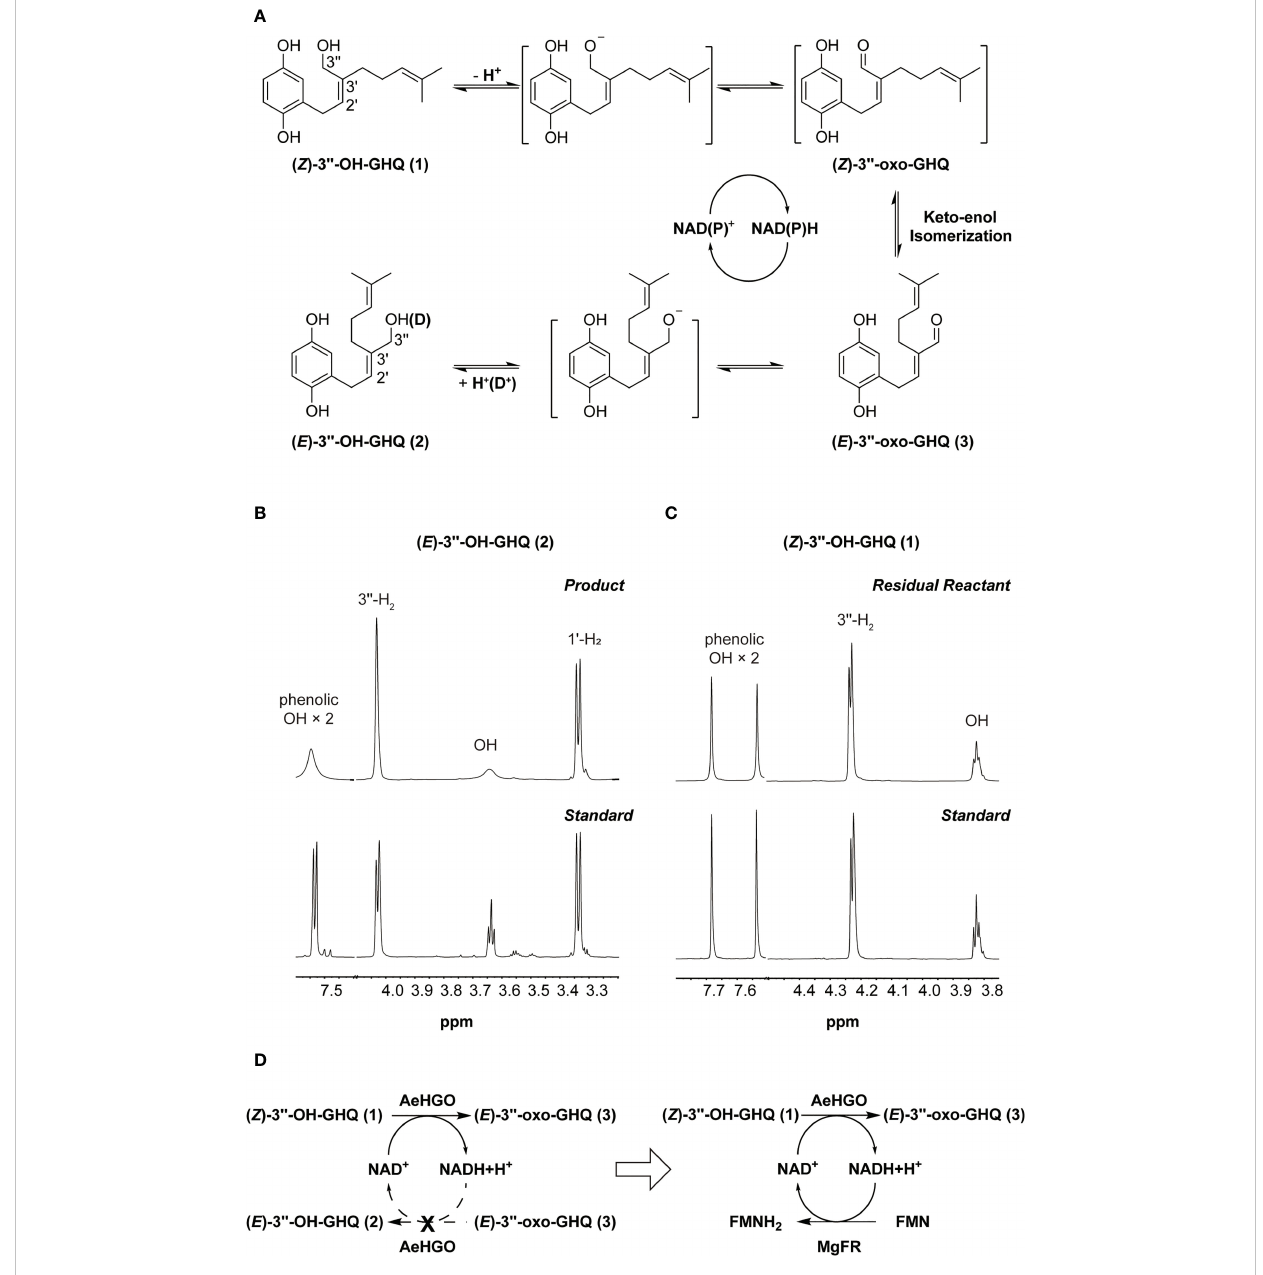
FIGURE 6 A proposed mechanism for reaction catalyzed by AeHGO. (A) Schematic diagram of AeHGO-catalyzed reversible reaction. ( Z )-3 ’’ -oxo-GHQ and the other transition states are shown inside the brackets. Hydrogen/deuterium exchange is shown inside parentheses. (B) Changes in 1 H spectrum pattern of phenolic hydroxyls, alcoholic hydroxyl, 1 ’ -H 2 , and 3 ’’ -H 2 of the enzymatic product ( E ) -3 ’’ -OH-GHQ ( 2 ) after the reaction in D 2 O. Chemically synthesized ( E ) -3 ’’ -OH-GHQ ( 2 ) was used as a control. (C) Changes in 1 H spectrum pattern of phenolic hydroxyls, alcoholic hydroxyl, and 3 ’’ -H 2 of the residual reactant ( Z )-3 ’’ -OH-GHQ ( 1 ) after the reaction in D 2 O. Chemically synthesized ( Z )-3 ’’ -OH-GHQ ( 1 ) is used as a control. (D) Symbolic graph displaying the introduction of a competitive pathway. Dashed arrows signify the original pathway which is replaced by the arti fi cially engineered competitive